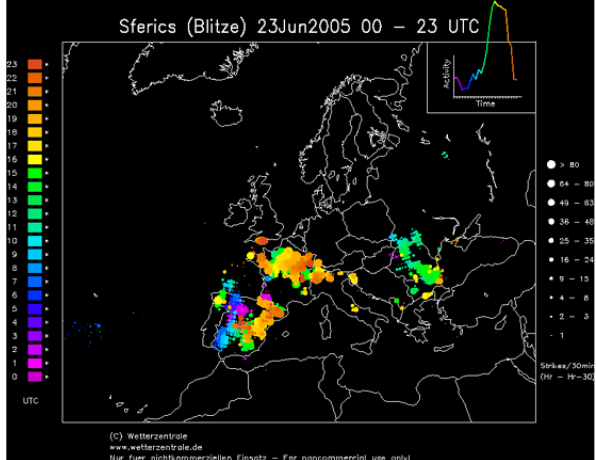
Fig. 15. Date: 2 July 2001, CL5. Spatial, temporal and intensity distribution of lightning events.